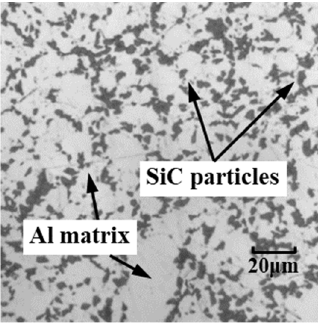
Figure 1. Microstructure of the SiC p/Al composite.